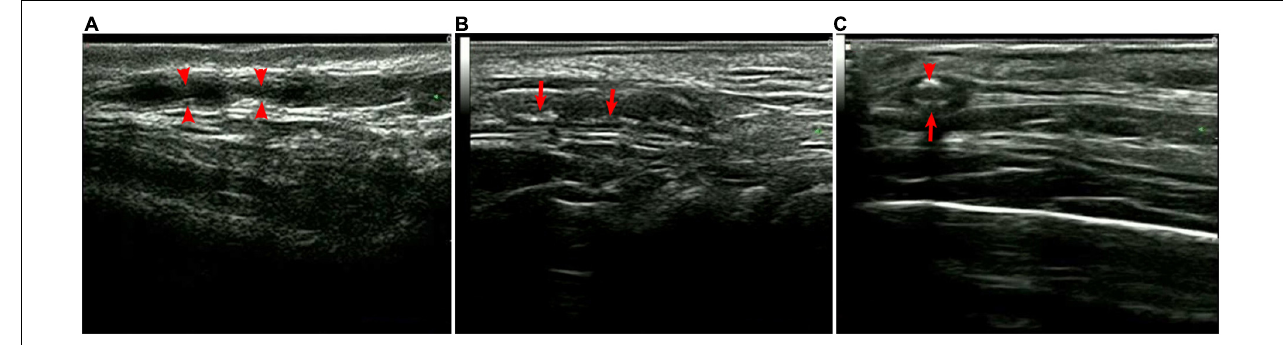
FIGURE 3 | Superficial temporal artery ultrasound. (A) Segmental stenosis (arrows); (B) segmental thickening with calcification (arrows), and (C) hypoechoic halo (large arrow) with calcification (small